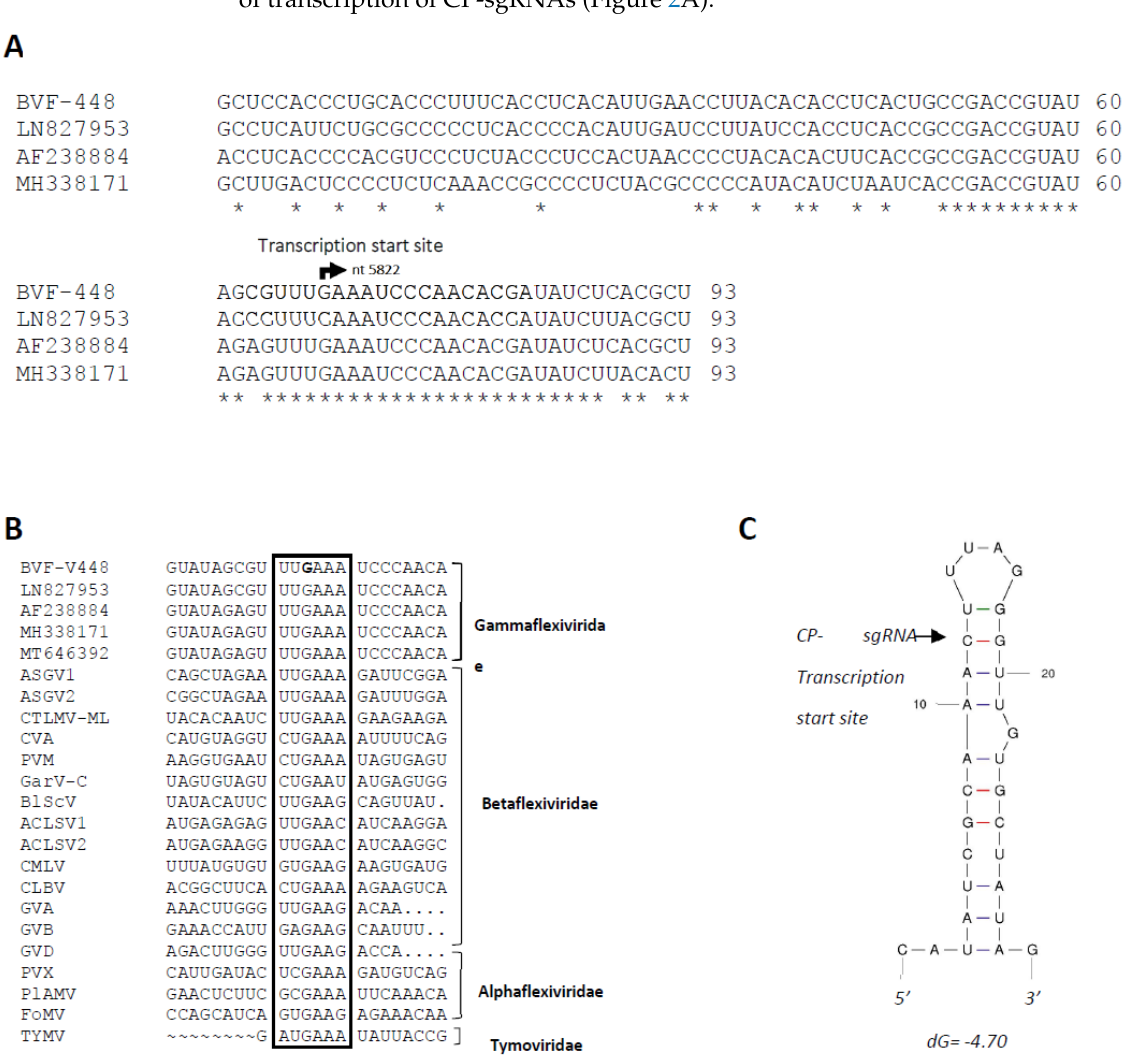
Figure 2. Analysis of BVF CP-sgRNA transcription initiation site. ( A ) Alignment of nucleotide sequences of the genomic RNA from different isolates showing the transcription initiation site of CP-sgRNA of BVF. The bent arrow indicates putative start transcription site at genome nt 5822. Comparison of the Spanish BVF CP sgRNA sequence (OM928008) with those previously published (LN827953, AF238884 and MH338171) and putative promoter sequences for the sgRNAs among other viruses; ( B ) Alignment of the sequence around the transcription start site of different viruses of the families Tymoviridae , Alphaflexiviridae , Betaflexiviridae , and Gammaflexiviridae inside the order Tymovirales . The highly conserved hexanucleotide is inside a box, with the starting nucleotide of BVF-V448 in bold. ( C ) Predicted secondary structure of the sequence around the BVF CP-sgRNA of BVF. The transcription initiation site of the CP is indicated with an